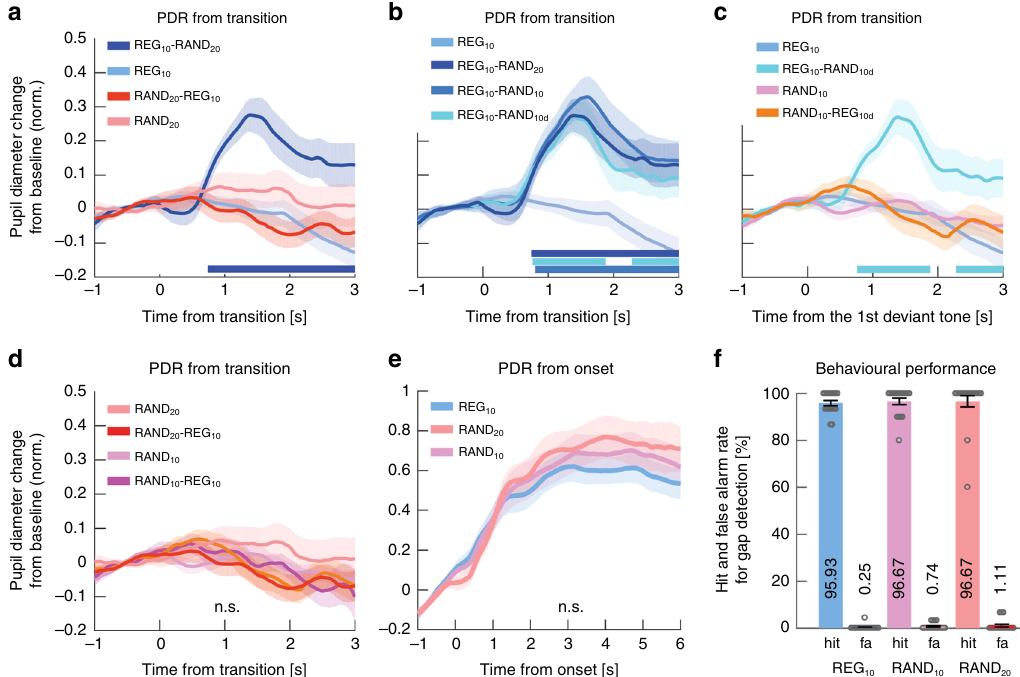
Fig. 5 The PDR re fl ects sensitivity to ‘ pure ’ pattern violations. a – d Average pupil diameter over time relative to the transition in Experiment 2 ( n = 18). Colored horizontal lines indicate time intervals where cluster-level statistics showed signi fi cant differences between each change condition and its no- change control. a The pupil responses to REG 10 -RAND 20 , RAND 20 -REG 10 and their respective controls replicated the pattern observed in Experiment 1: REG 10 -RAND 20 diverged from REG 10 at 740 ms post-transition; RAND 20 -REG 10 did not differ statistically from RAND 20 . b A signi fi cant PDR was observed for all conditions containing transitions from REG 10 . The PDR in REG 10 -RAND 10 increased from 420 ms, and statistically diverged from REG 10 800 ms post- transition, peaking at 1600ms; the PDR to REG 10 -RAND 10d diverged from REG 10 at 760 ms up to 1880ms, peaking at 1380 ms. c A comparison between the two conditions which contained a change in alphabet at the transition (REG 10 -RAND 10d , RAND 10 -REG 10d ). Only REG 10 -RAND 10d evoked a PDR. d None of the stimuli containing transitions from RAND 10 evoked a signi fi cant PDR. e Average pupil diameter over time, from stimulus onset. No differences were observed between any of the conditions. f Behavioral results for the gap detection task. Error bars are ± 1 SEM; gray circles represent individual